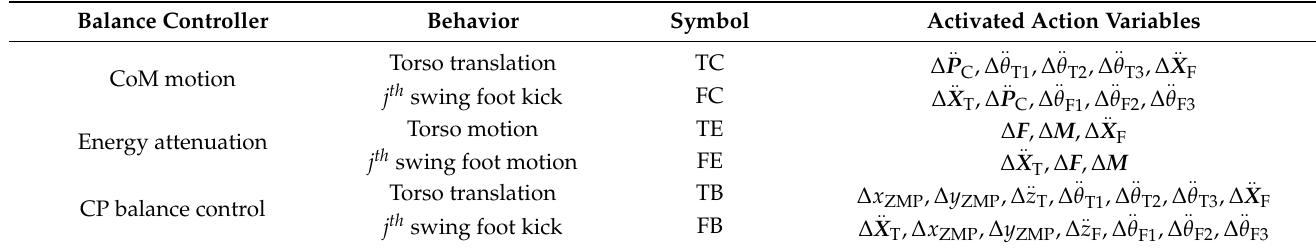
Table 5. Model-based balance controller for global self-stabilizer training data